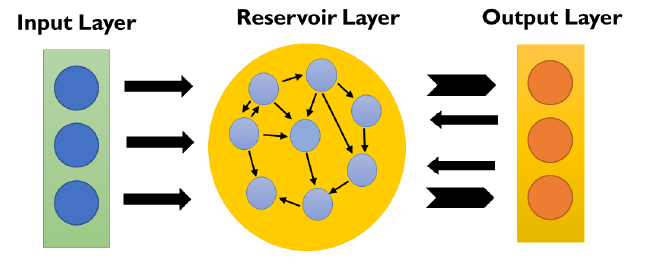
Figure 1. Schematic diagram of the structure of reservoir